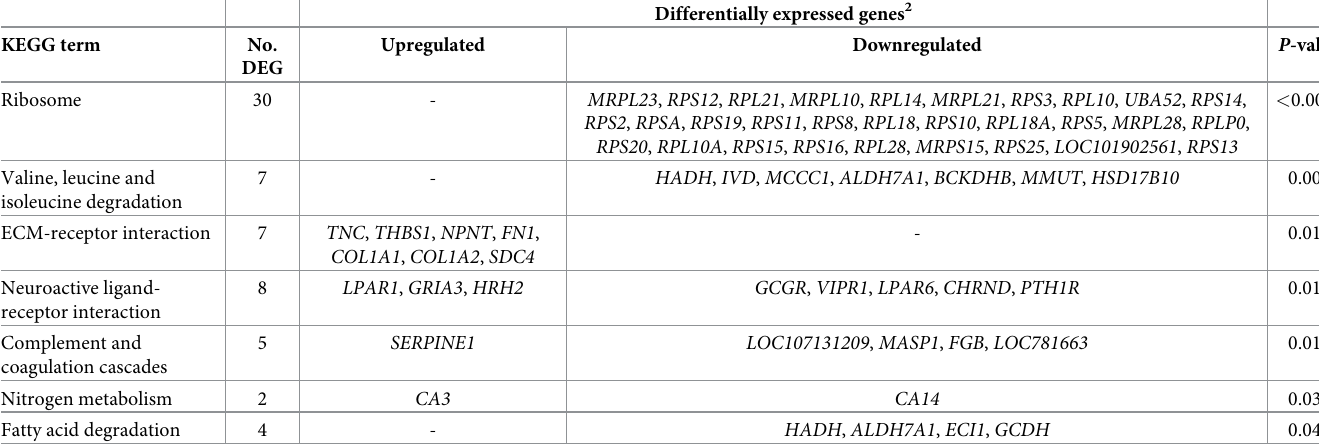
Table 3. Significantly enriched Kyoto Encyclopedia of Genes and Genomes (KEGG) pathways in the Longissimus dorsi muscle of early-weaned Bos indicus -influ- enced calves for the effect of time (pre- vs. post- vaccination) 1